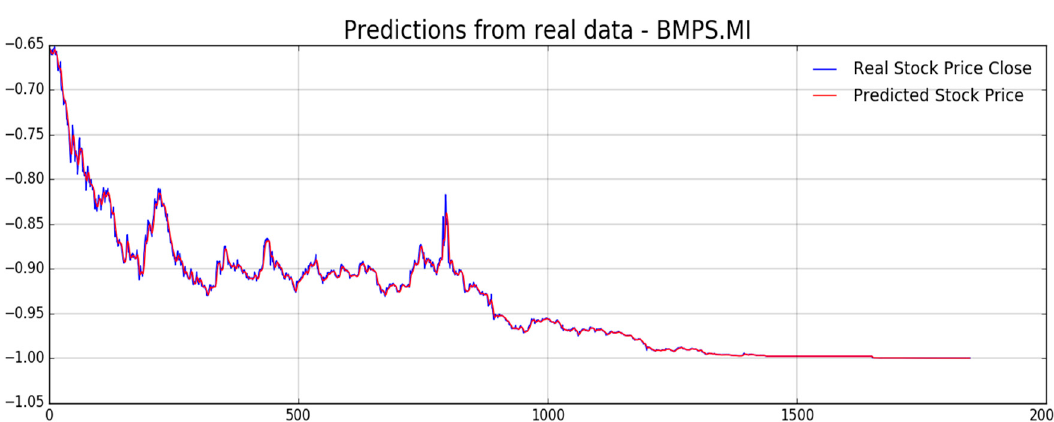
Figure 13. BMPS.MI Close Price time-serie (red: predicted without Markov correction; blue: real value).